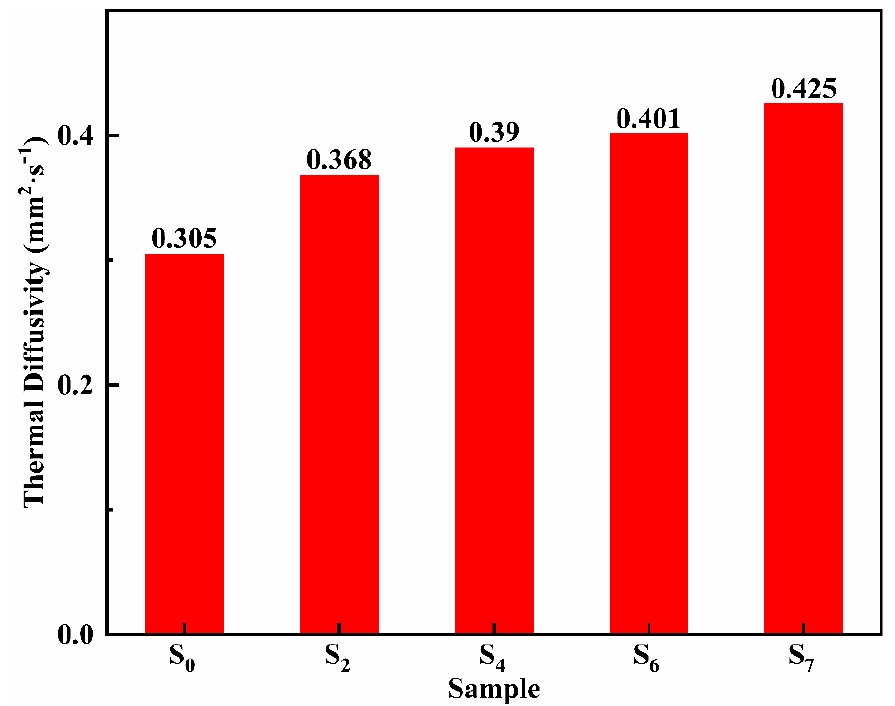
Figure 8. Thermal diffusivity of S 0 , S 2 , S 4 , S 6 , and S 7 . To explore the heat transfer performance of the modified nitrate, the samples S 0 , S 2 , S 4 , and S 6 were placed on a heating plate, and an infrared thermal imaging instrument was used to characterize the heat transfer performance of the material. Figure 9 shows the infrared thermal images of samples S 0 , S 2 , S 4 , and S 6 heated on the heating plate for different times. The heat is transferred upward from the bottom end. The heat transfer rate from sample S 0 to sample S 6 shows an increasing trend, and the transfer rate of sample S 6 is the fastest at the same time. Plot the temperature of samples S 0 , S 2 , S 4 , and S 6 at the same geometric position with heating time, as shown in Figure 10. It can be seen that the heat transfer performance of the material increases with the increase of MgO nanoparticles. The doping of nanoparticles enables the material to transfer heat in the solid state quickly, accelerating the heat transfer process of the material, thus shortening the time required for the phase change of the material, and more efficiently storing thermal energy. At the same time, when the material acts as a nanofluid in a liquid state, the heat transfer performance is greatly improved, and the heat transfer process is accelerated. The results show that modified nitrate has high sensible heat and latent heat, a suitable phase transition temperature, and high thermal conductivity, which can improve the energy storage efficiency and can be used in thermal energy storage